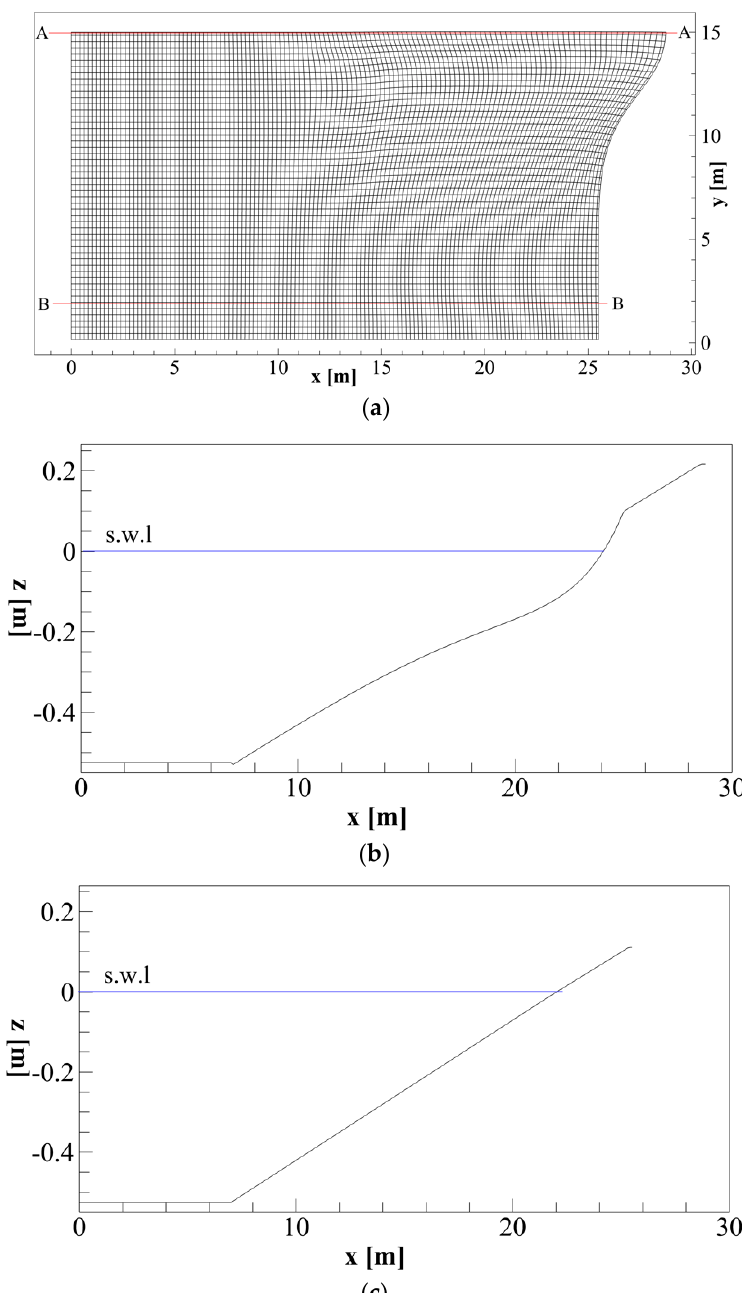
Figure 7. Test 4. Rip current. ( a ) computational grid (only one line in every 5 is drawn). ( b ) bottom profiles along Section A. ( c ) bottom profile along Section B.